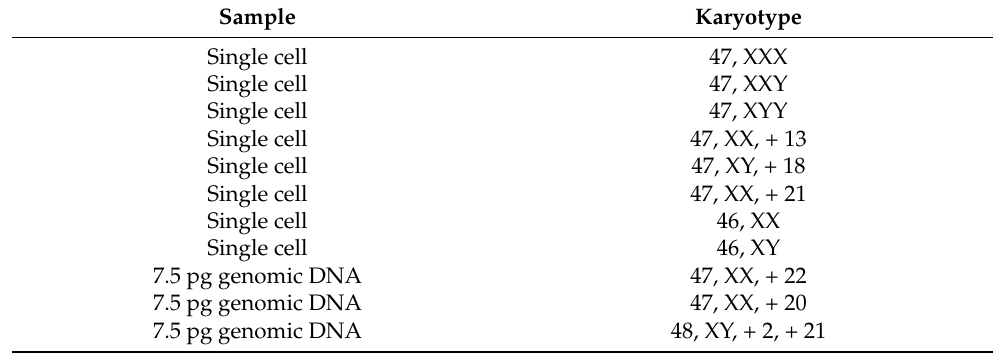
Table 3. Validation of NGS methodology. Sample